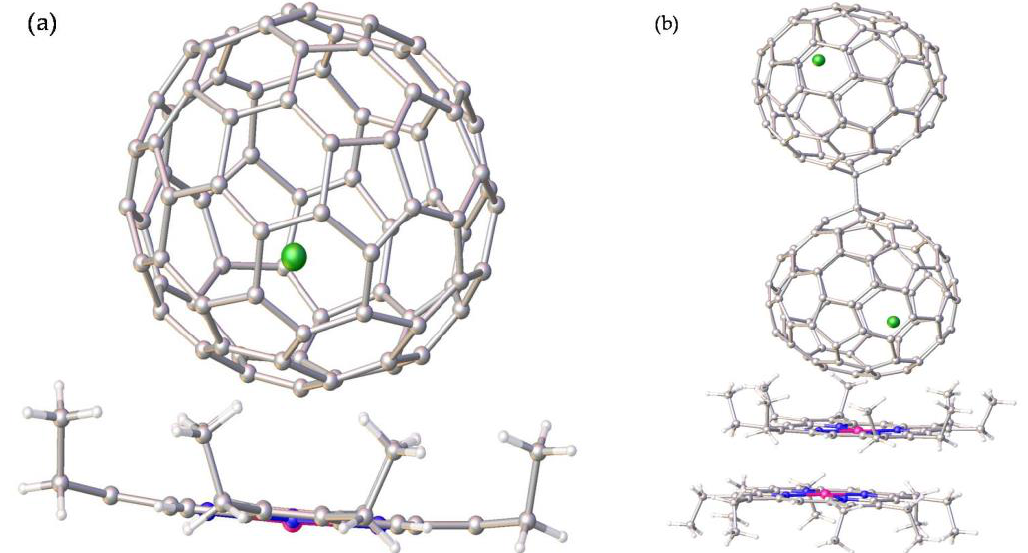
Figure 4. The orientations of ( a ) Tb@C 2v (9)-C 82 and ( b ) Tb@C S (6)-C 82 to Ni(OEP) in the cocrystals of Tb@C 2v (9)-C 82 ]∙[Ni(OEP)] and 2[Tb@C S (6)-C 82 ]∙2[Ni(OEP)], respectively. Only the major Tb site and one carbon cage orientation are shown. Solvent molecules and H atoms are omitted for clarity.